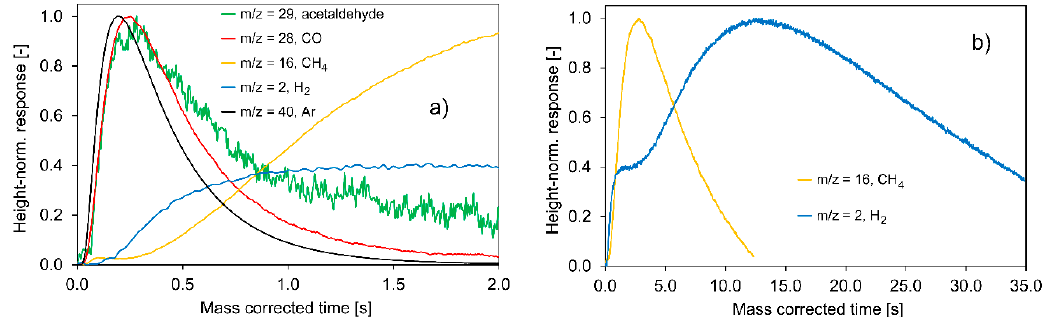
Figure 4. Height-normalized transient responses to pulses of 34.6 vol % ethanol in Ar on the H 2 pre-reduced Pt/C catalyst (20 mg), T = 200 °C, at m/z-values of: ( a ) 2 for H 2 , 16 for CH 4 , 28 for CO, 29 for acetaldehyde and 40 for Ar up to 2.0 s; ( b ) 2 for H 2 and 16 for CH 4 over the entire time-span.